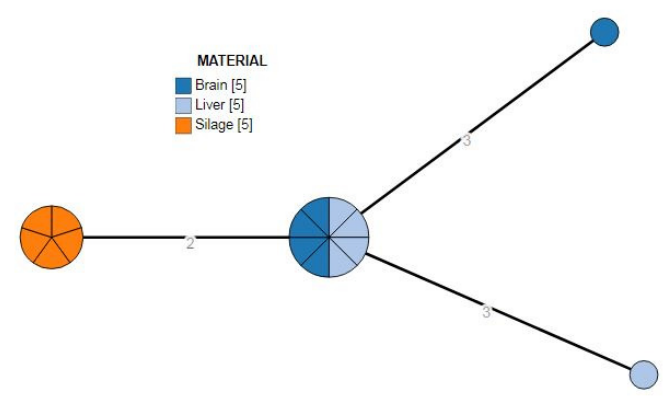
Figure 2. cgMLST of the 15 L. monocytogenes strains.